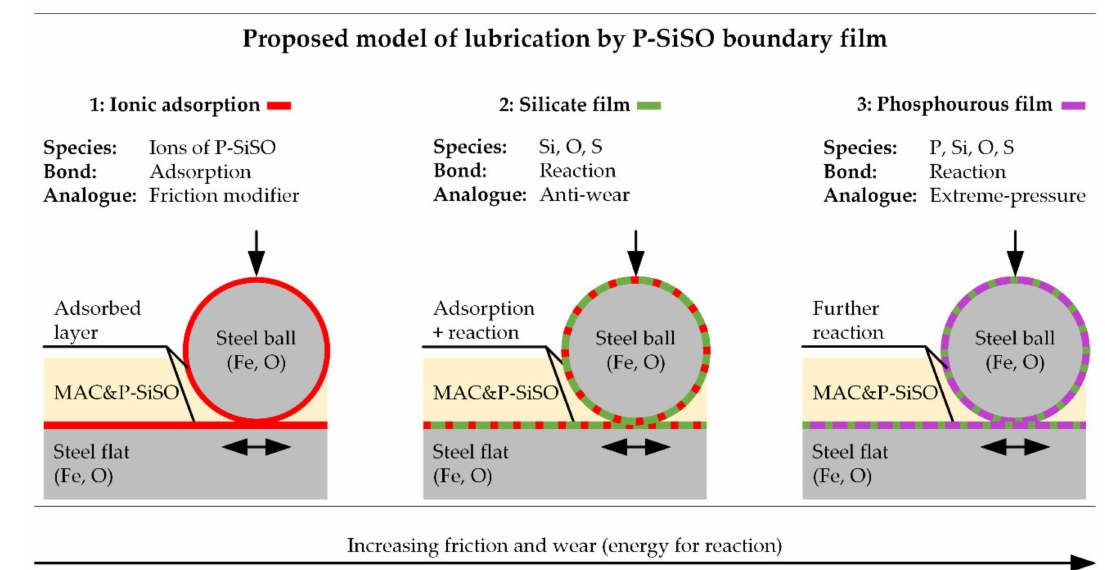
Figure 11. Proposed model of boundary film formation with P-SiSO, based on surface analysis. Ionic adsorption is followed by chemical reactions of silicate and eventually phosphate as the energy available for chemical reactions